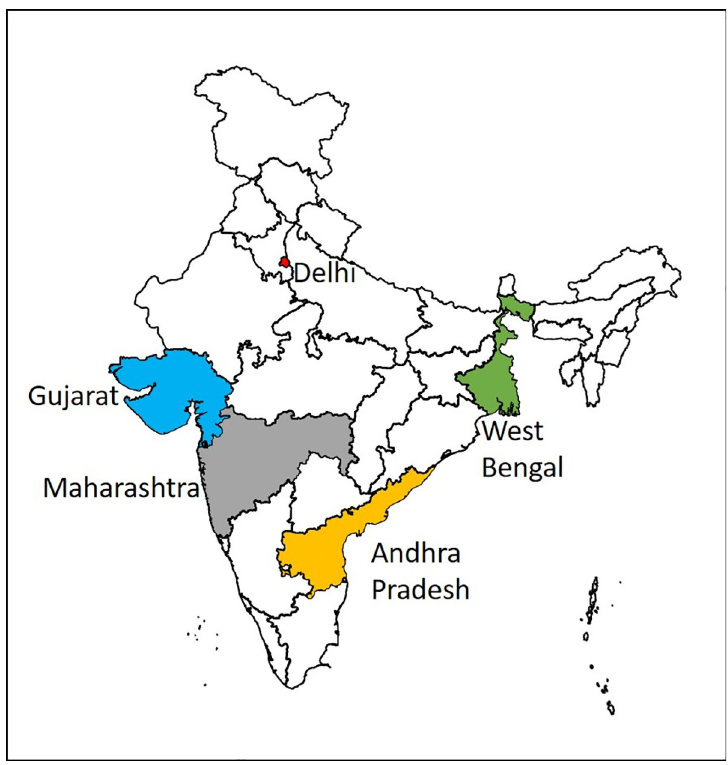
Fig 1. Geographic representation of data collection states in